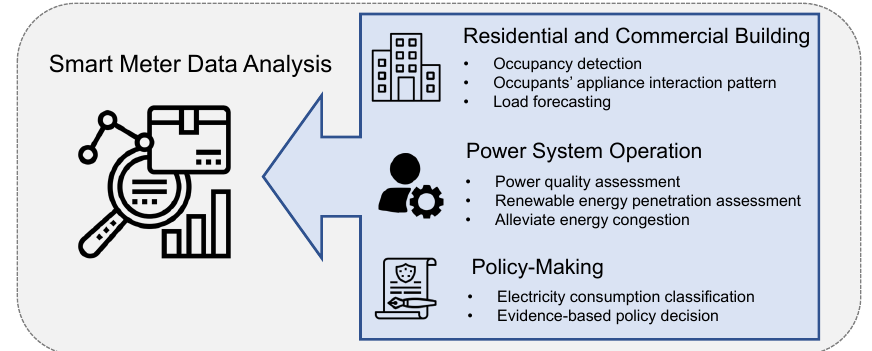
Figure 10. Aspects that smart meter data analysis is dedicated to